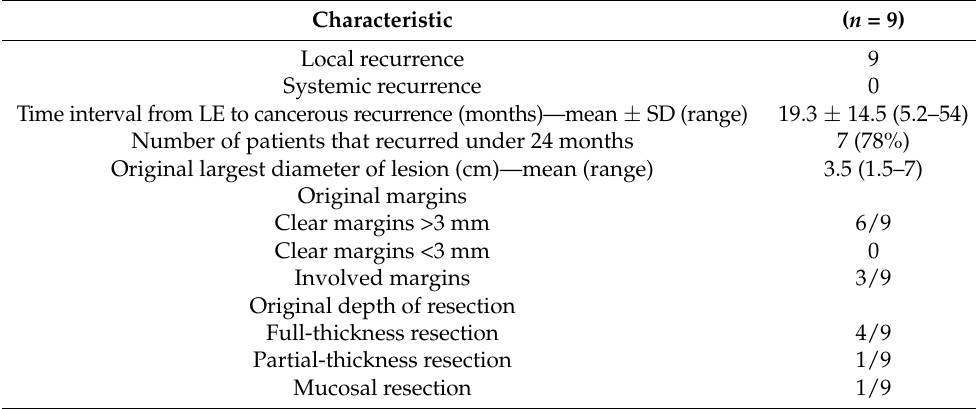
Table 3. Characteristics of recurrence